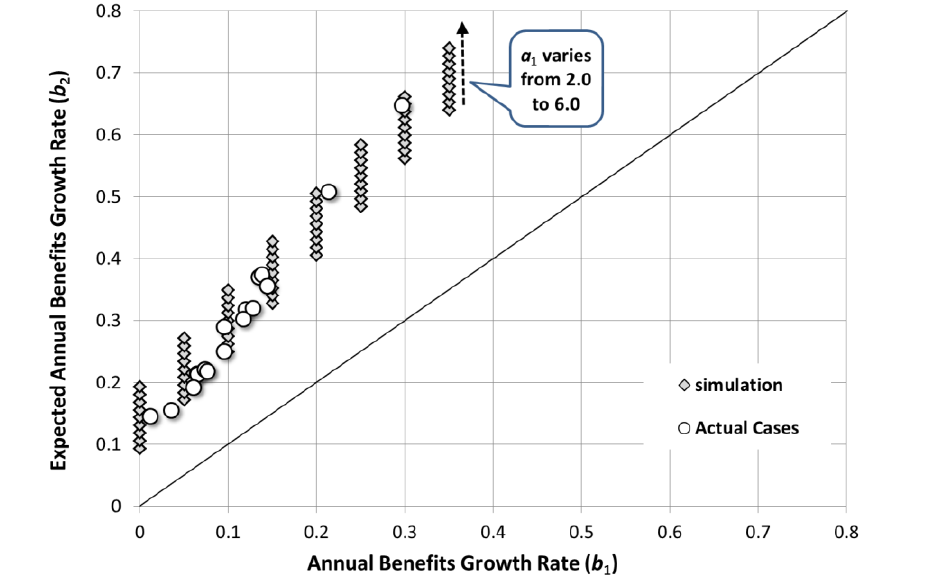
Figure 6. Gain in efficiency on the growth of benefits b